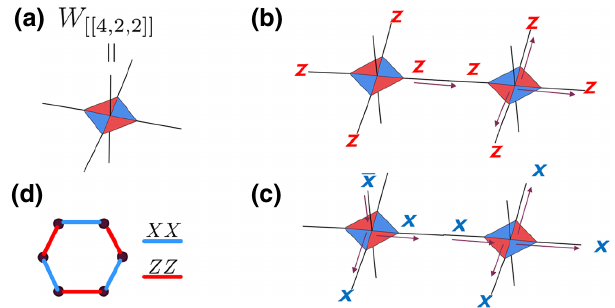
FIG. 4. (a) Encoding map of the [[4, 2, 2]] code as a rank-6 tensor. We naturally represent it as a six-legged tensor where the in-plane legs correspond to the four physical qubits and the other two legs correspond to logical degrees of freedom. The colors are used to denote its orientation. (b) Generating a stabilizer opera- tor ZZZZZZ from pushing. (c) Physical representation of logical ¯ X of the left tensor across the connected ¯ I ¯ I ¯ I ¯ X 1 2 3 4 by pushing edge to the right tensor using a stabilizer (logical identity) of the right tensor. (d) The resulting [[6, 2, 2]] gauge code where the generators of the gauge group are XX , ZZ operators that act on the endpoints of the colored